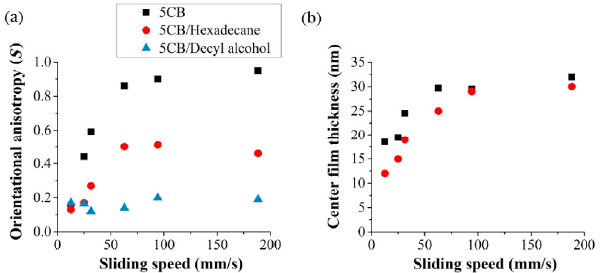
Fig. 10 (a) Variation of S with sliding speed; (b) the variation of lubricating film thickness with sliding